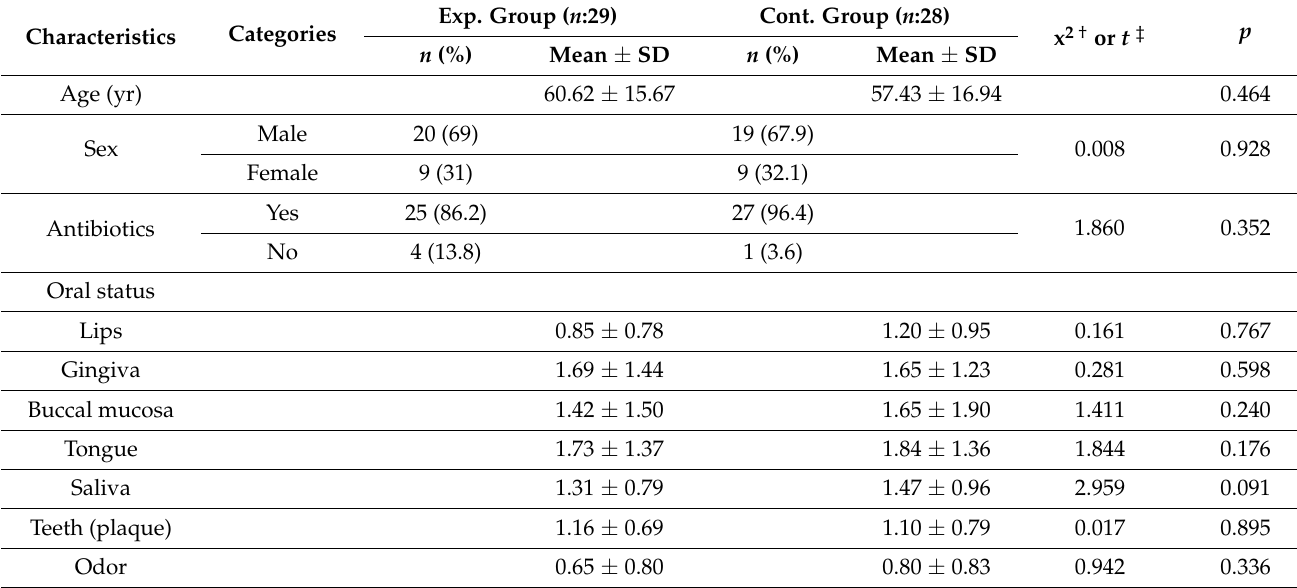
Table 1. General patient characteristics and oral health